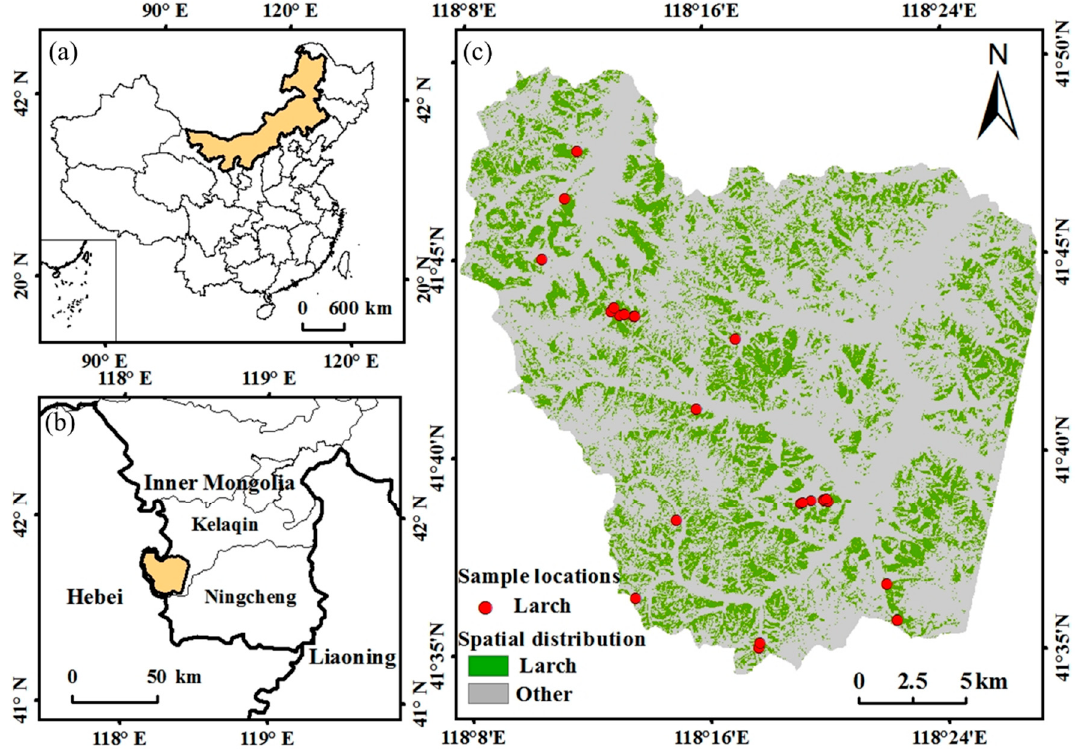
Figure 1. The study area: ( a , b ) the location of the study area in North China, ( c ) larch spatial distribution and surveyed sample locations.